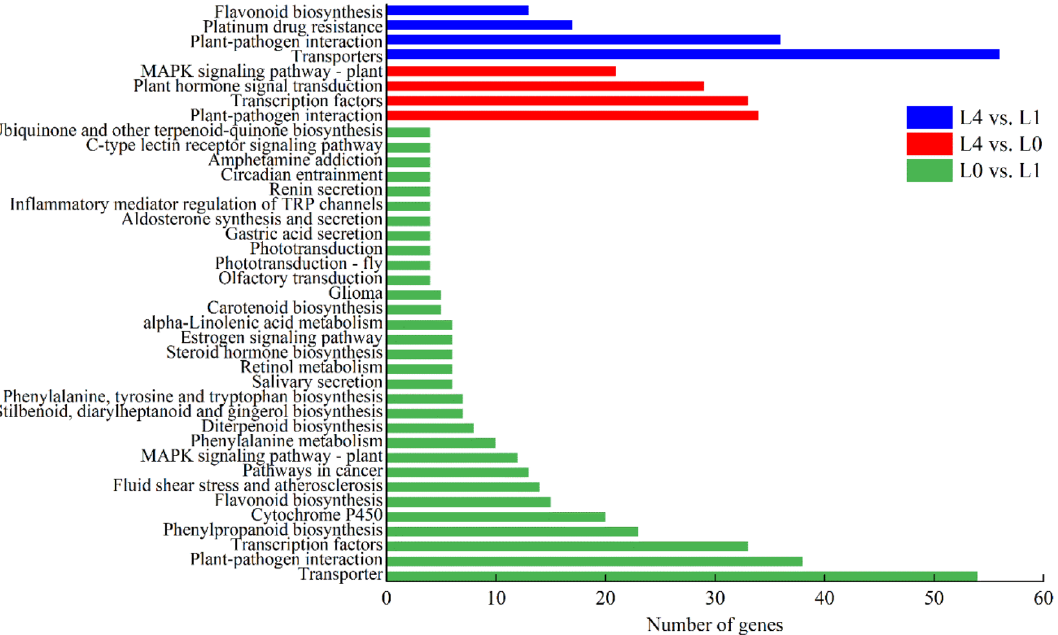
Figure 5. Significantly enriched KEGG enrichment of DEGs from the three different treatment